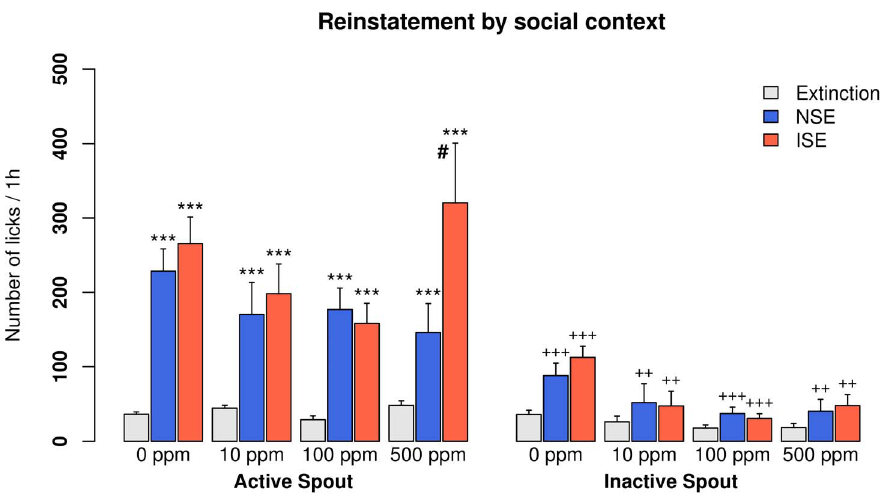
Fig. 5. Context-induced drug-seeking in rats self-administering nicotine with an olfactogustatory cue and different concentrations of CS 2 . The nicotine self-administration environment induced strong drug- seeking behavior in all nicotine groups. In rats that received 500 ppm CS 2 during self-administration, the inducing social environment induced a significantly greater amount of drug-seeking behavior compared to the neutral social environment. ***: p , 0.001 compared to extinction; ++ : p , 0.01 compared to the active spouts; +++ : p , 0.001 compared to the active spouts; #: p , 0.05 compared to NSE. NSE: the neutral social environment; ISE: the inducing social